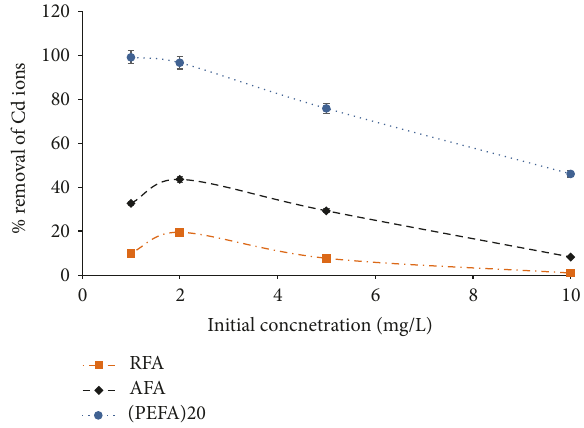
Figure 13: The influence of initial concentration on the removal efficiency of Cd (II) ions on FA based adsorbents (RFA, AFA, and PEFA) as a function of pH value of 9, 150rpm mixing rate, contact time of 15 min, 4 g/L adsorbent dosage, 50 mL volume of aqueous solution, and 298 K